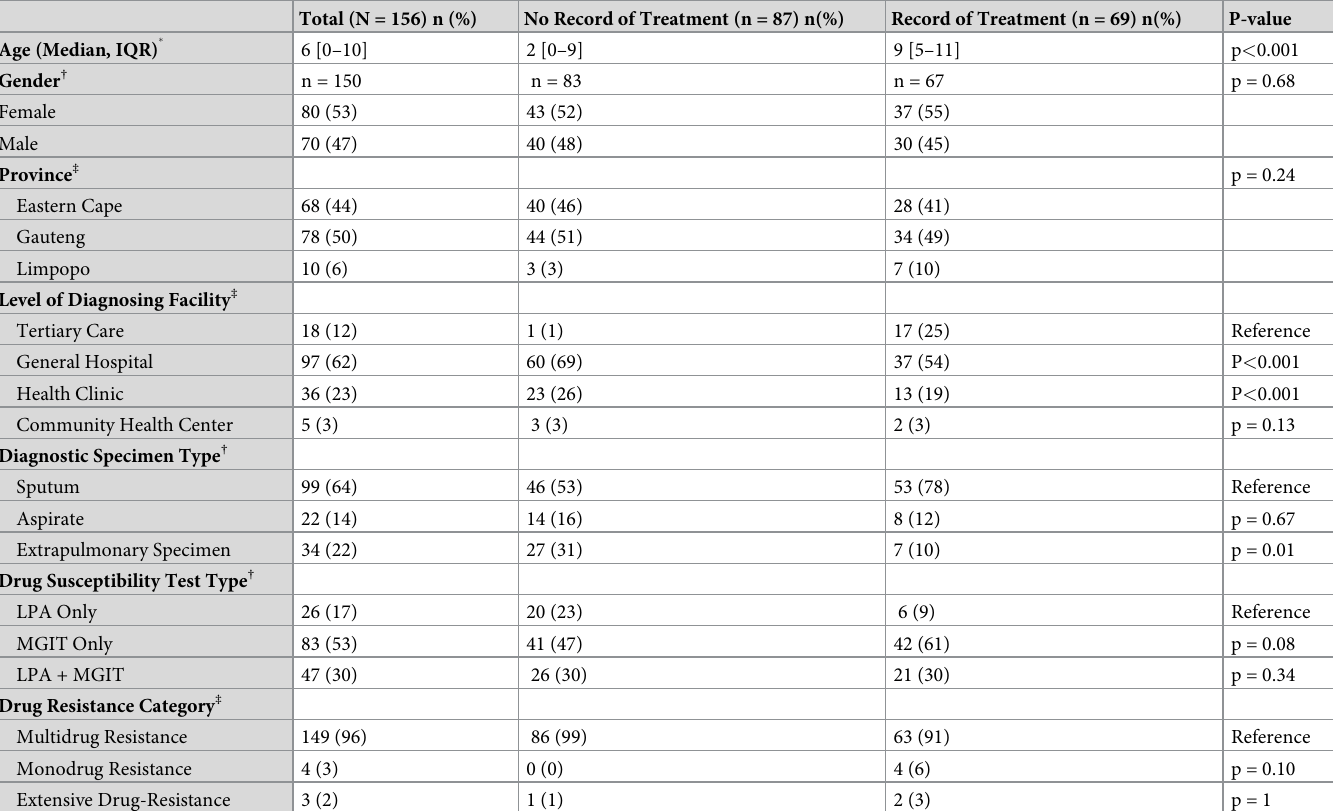
Table 1. Demographic and clinical characteristics of children with laboratory-confirmed drug-resistant TB in three provinces of south Africa 2008–2010 by record of treatment at designated treatment facilities (N =